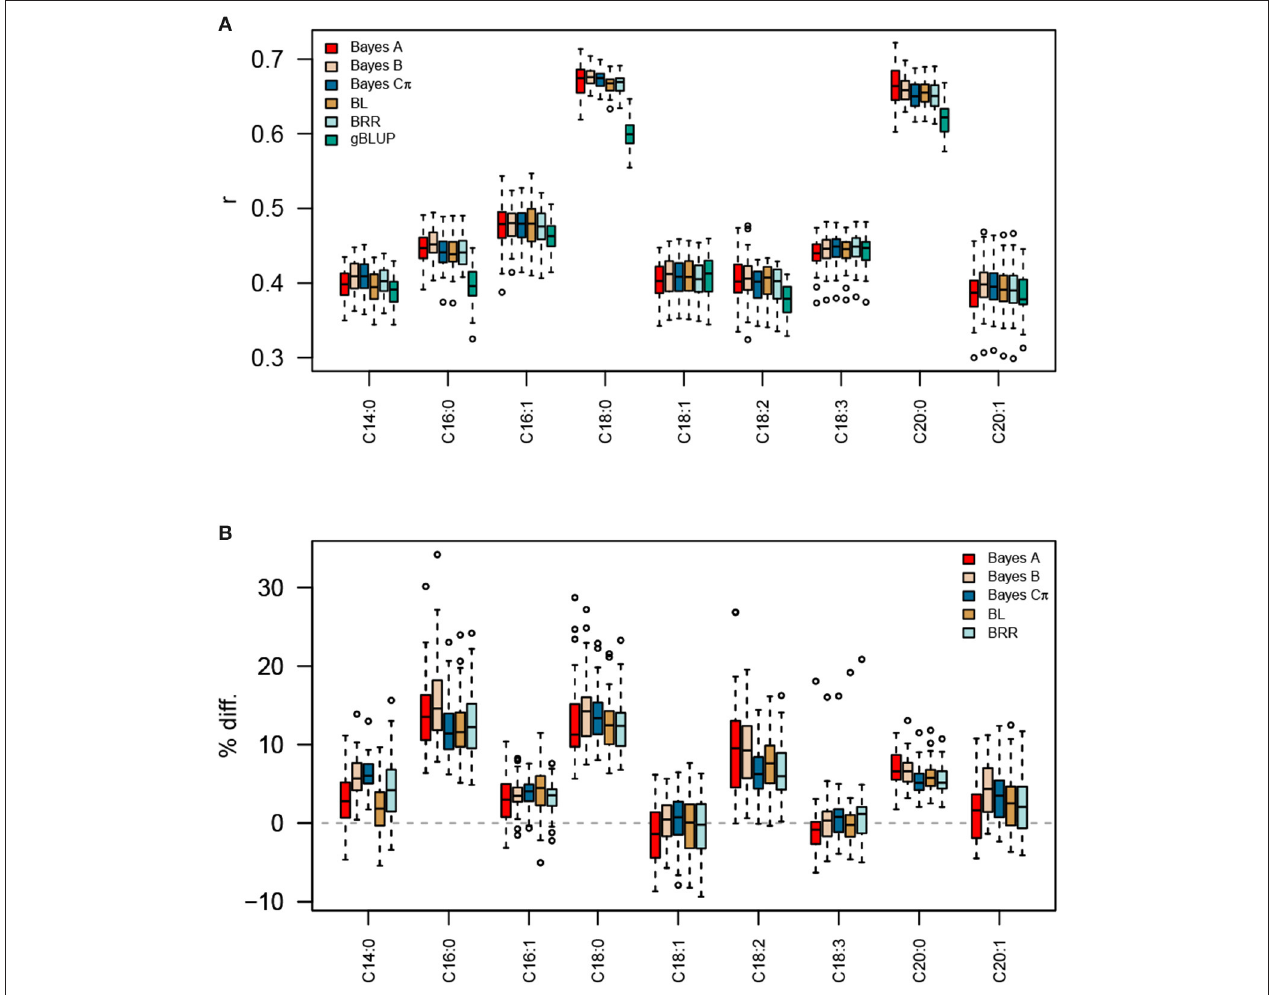
FIGURE 2 | Prediction accuracies for fatty acid traits using TGRM-BLUP and gBLUP. Five Bayesian whole-genome regression approaches (Bayes A, Bayes B, Bayes C π , BRR, and BL) were used to estimate marker effects for each fatty acid trait in the Diversity Panel. These marker effects were used to construct trait-specific genomic relationship matrices (TGRM) and were used to predict fatty acid abundances in the Elite Panel. Prediction accuracy was assessed using five-fold cross validation with 50 resampling runs. The correlation between predicted genomic breeding values in the testing population and the observed phenotypes is shown in (A) . Panel (B) shows the percent improvement relative to genomic BLUP (gBLUP) for each trait. BL, Bayesian LASSO; BRR, Bayesian ridge regression; r , Pearson’s correlation